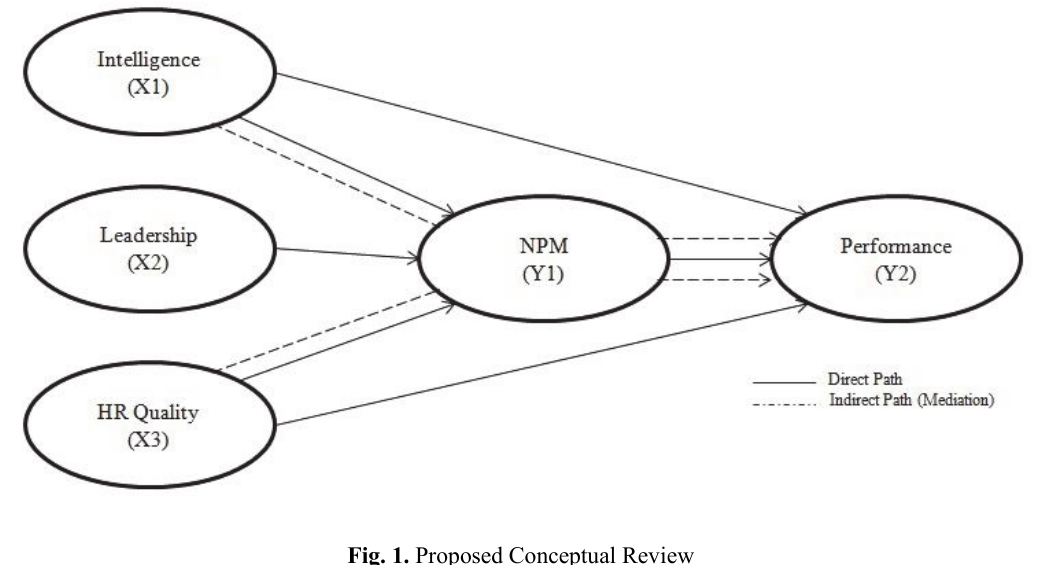
Fig. 1. Proposed Conceptual